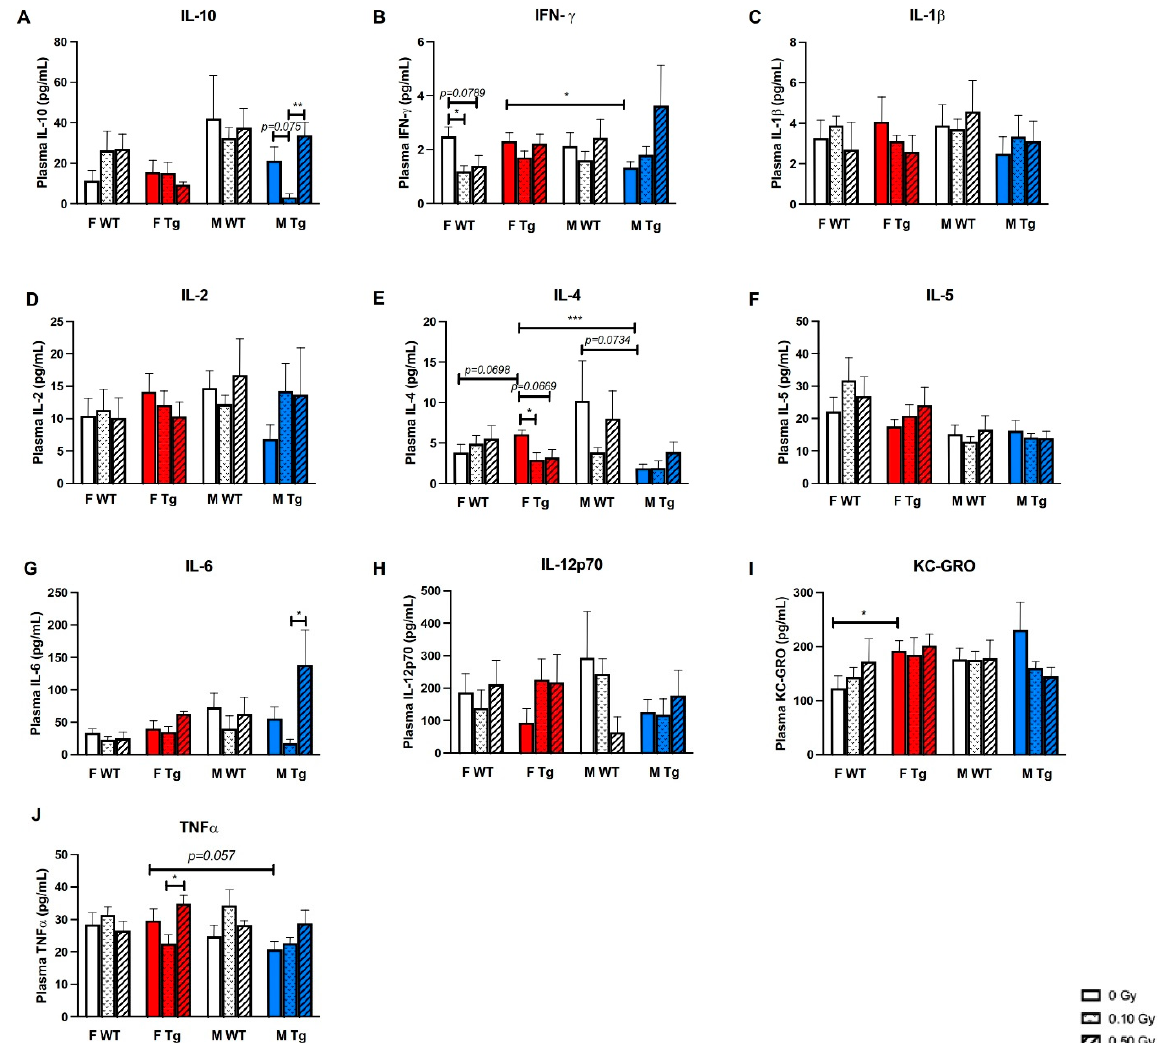
Figure 4. Low-dose 56 Fe irradiation lowered plasma levels of IL-10 in male APP/PS1 mice compared with sham-irradiation controls. a–j Plasma levels of 10 cytokines, IL-10 ( A ), INF- γ ( B ), IL-1 β ( C ), IL-2 ( D ), IL-4 ( E ), IL-5 ( F ), IL-6 ( G ), IL-12p70 ( H ), KC-GRO ( I ), and TNF- α ( J ), were measured by MSD ELISA. No significant late effects of 56 Fe irradiation on plasma cytokines were observed, except low-dose irradiation resulted in an overt reduction in IL-10 in male APP/PS1 mice and IL-4 in APP/PS1 female mice versus sham-irradiated male and female APP/PS1 controls ( A , E ), as well as a reduction in IFN- γ in WT females ( B ). We saw baseline genotype effects on levels of KC-GRO ( I ) and baseline sex effects in APP/PS1 shams on levels of IFN- γ ( B ) and IL-4 ( E ) n = 5–7 mice/group. * p < 0.05, ** p < 0.01, *** p < 0.001. Data were analyzed by 3-way ANOVAs followed up with 1-way ANOVAs with Tukey comparisons and planned, unpaired, 2-tailed t tests between sham groups as necessary. Non-parametric data were analyzed with the Kruskal–Wallis and/or Mann–Whitney U tests.